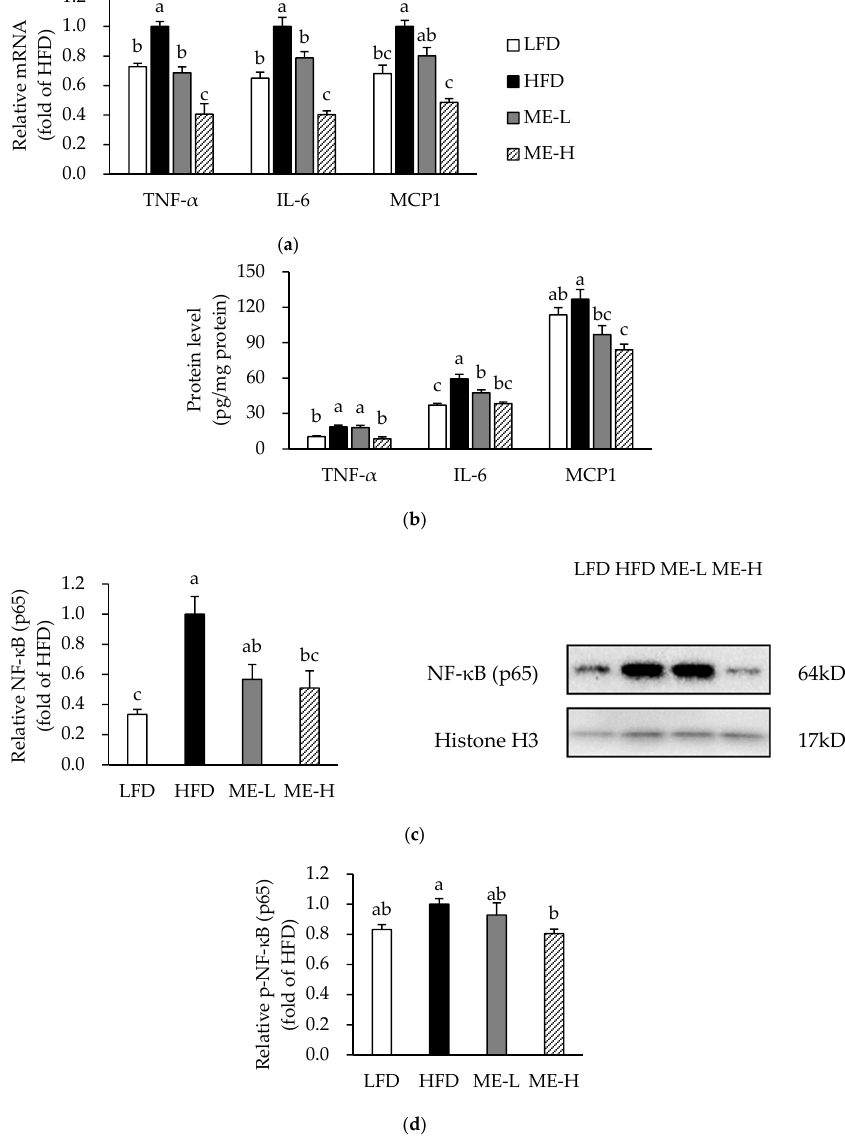
Figure 2. Effect of mulberry fruit extract on inflammation in white adipose tissue. ( a ) mRNA expression of pro-inflammatory cytokines. The mRNA levels were normalized relative to the β -actin. ( b ) Protein levels of pro-inflammatory cytokines. ( c ) Nuclear NF- κ B p65 protein level. ( d ) Nuclear phosphorylated-NF- κ B p65 level normalized to the total protein concen- tration. Values are expressed as mean ± SEM (n = 8/group). Bars with different letters indicate a significant difference at p < 0.05. Abbreviations: LFD, low-fat diet; HFD, high-fat diet; ME-L, HFD + 5 g/kg diet of mulberry fruit extract; ME-H, HFD + 10 g/kg diet of mulberry fruit extract; TNF- α , tumor necrosis factor- α ; IL-6, interleukin 6; MCP1, monocyte chemoat- tractant protein 1; and NF- κ B, nuclear factor-kappa B.